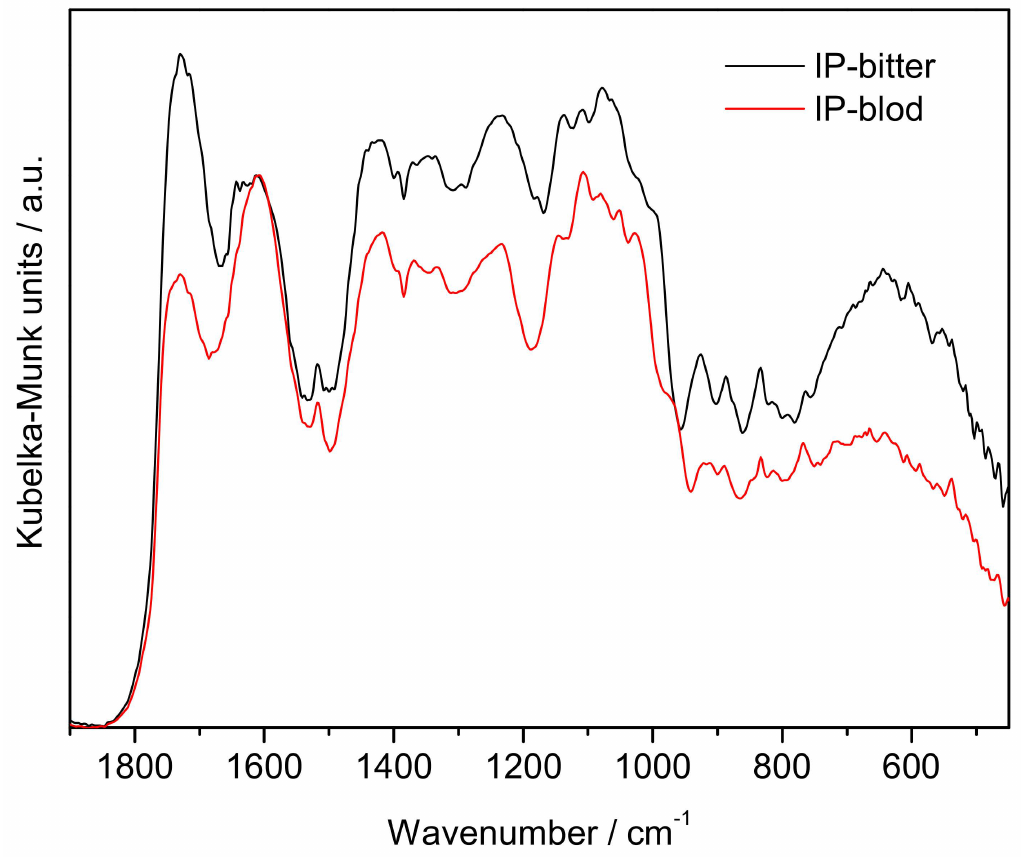
Figure 1. DRIFT spectra of the pectin samples in the 500–2000 cm − 1 region, normalized to the ν as COO − band carboxylate groups, at ~1610 cm − 1